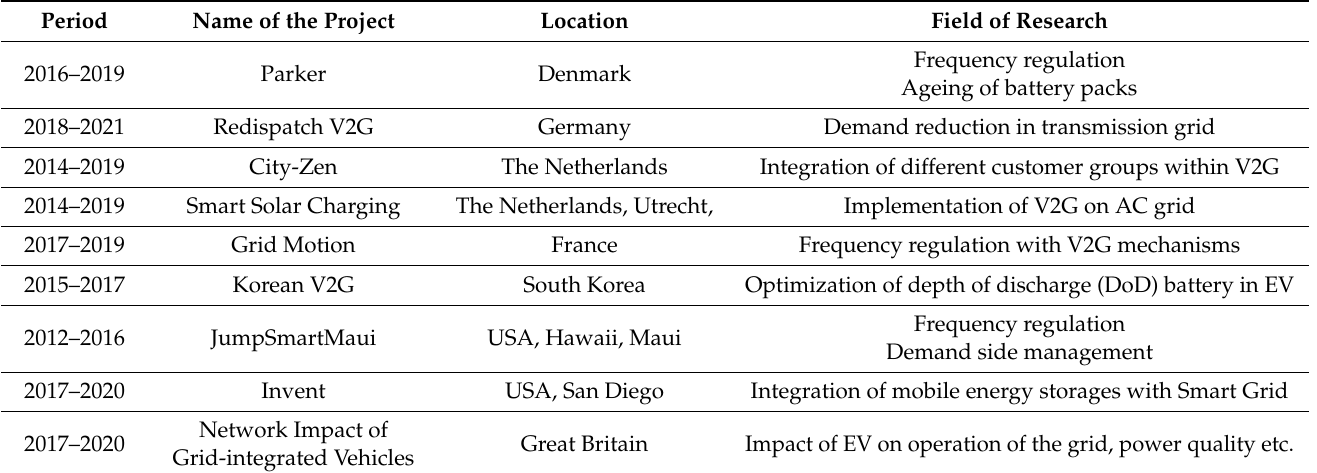
Table 1. Commercial Projects of V2G Technology—based on